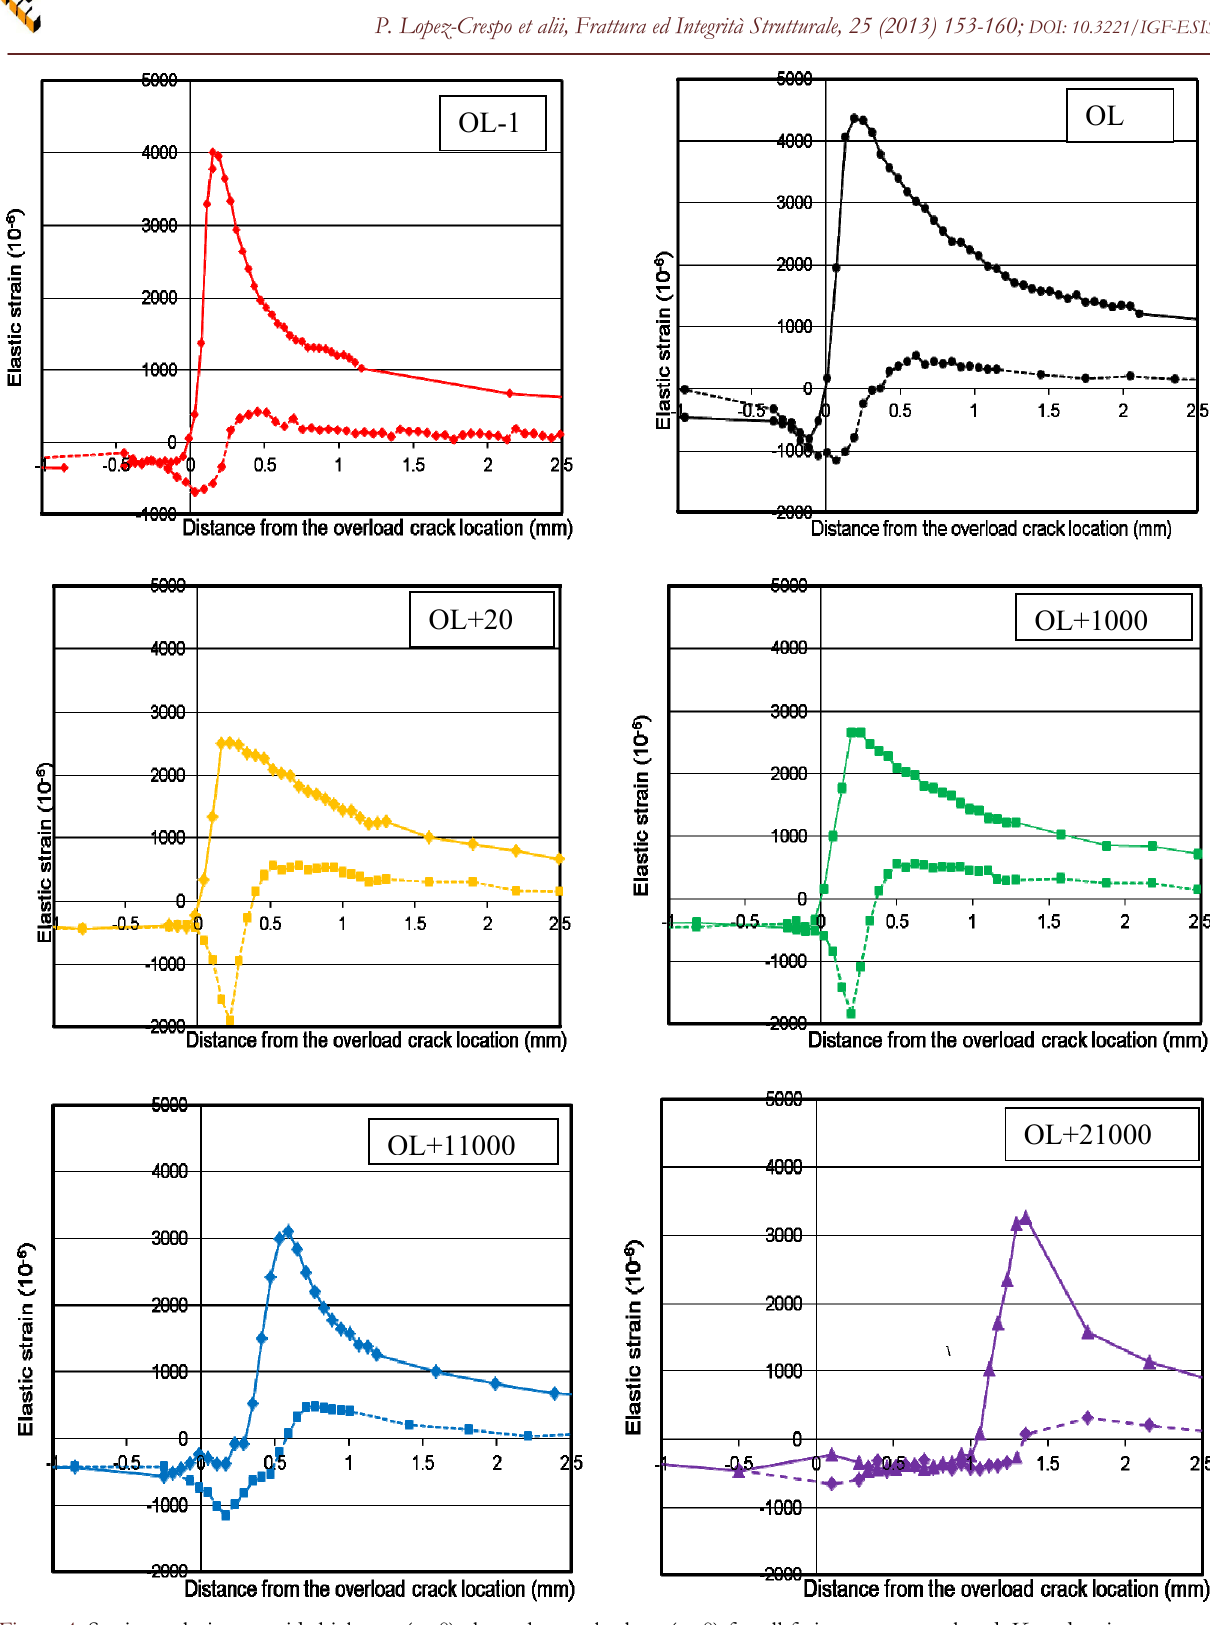
Figure 4: Strain evolution at mid-thickness (z=0) along the crack plane (y=0) for all fatigue stages analysed. K max data is represented by the solid line and K min data by the broken